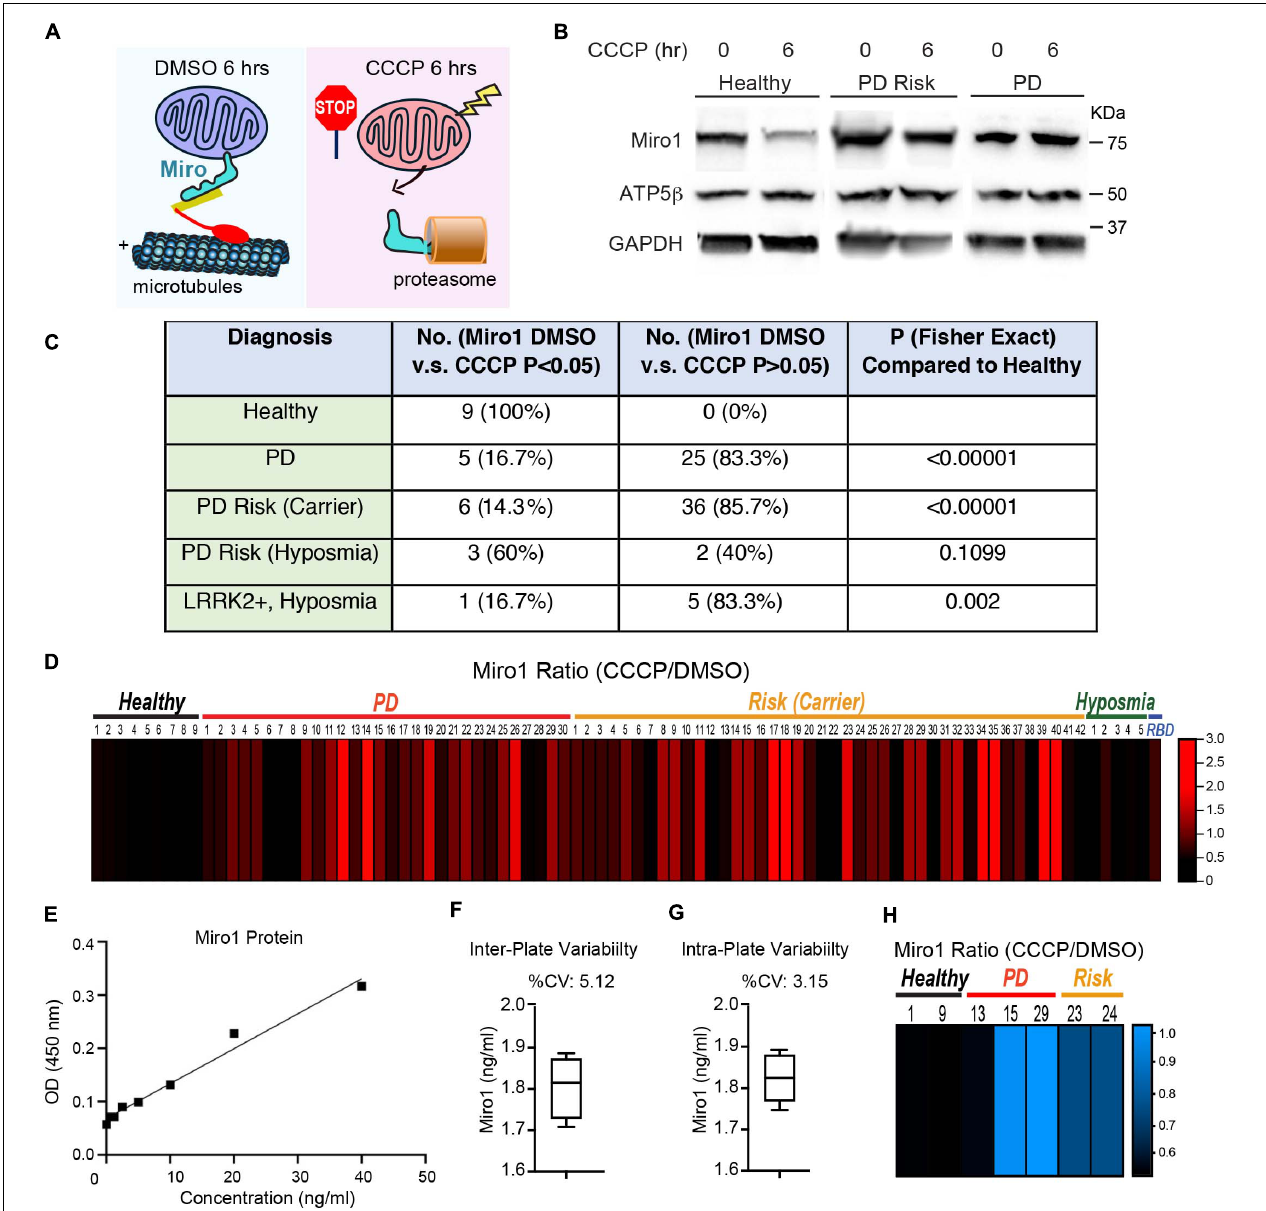
FIGURE 1 | The Miro1 Response to CCCP in iPSCs. (A) Schematic representation of our readout. (B) Examples of the readout using Healthy-2, PD-29, and Risk-39. Cell lysates were blotted as indicated. (C) Summary of the Western blotting results. Normalized Miro1 intensities of “with DMSO” and “with CCCP” within the same subject are compared by Student T Test, and the number of subjects with P > 0.05 together with subjects that show significant Miro1 upregulation after CCCP, or the number of subjects with P < 0.05 for Miro1 reduction after CCCP, is indicated in the column of “No. (Miro1 DMSO vs CCCP P > 0.05 or < 0.05).” Fisher Exact Test is used to determine the P value of a specific group in comparison with “Healthy.” (D) The heatmap shows the relative ratio of mean normalized Miro1 intensities (“with CCCP” divided by “with DMSO”) of the same subject measured by Western blotting. Data are from Supplementary Table 1 . n = 3–55. (E–G) Validation of ELISA for Miro1. (E) A representative standard curve is shown. LLOD = 0.112 ng/ml. Dynamic range = 0.625–40 ng/ml. (F) Inter-plate variability is demonstrated by measuring the same sample (Healthy-1) in 4 different plates. (G) Intra-plate variability is shown by measuring the same sample (Healthy-1) 4 times in the same plate. (H) The heatmap shows the relative ratio of mean Miro1 values (“with CCCP” divided by “with DMSO”) of the same subject measured by ELISA. Data are from Supplementary Table 1 . n = 3–4.